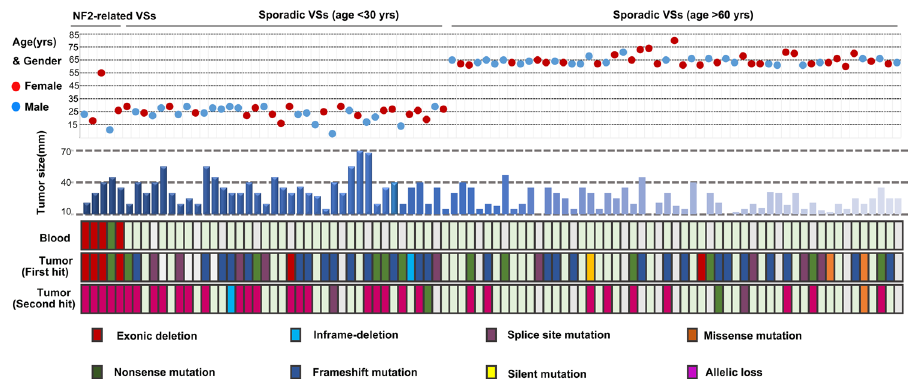
Figure 1. Clinical and genetic characteristics of young and elderly patients with sporadic VSs. The clinical parameters of both young (n = 38) and elderly (n = 53) patients with sporadic VSs, including the age at diagnosis, gender, and tumour size, were present in the upper panel. The screening for the mutation and the copy number of the NF2 gene was performed using a combination of Direct sequencing and MLPA analysis in these cases. Five NF2-related patients were used as positive